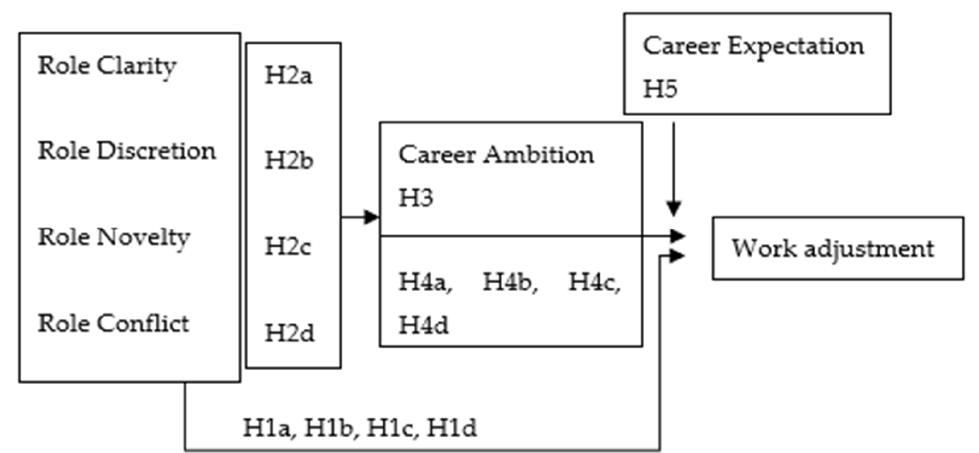
Figure 1. Research Figure 1. Research model.